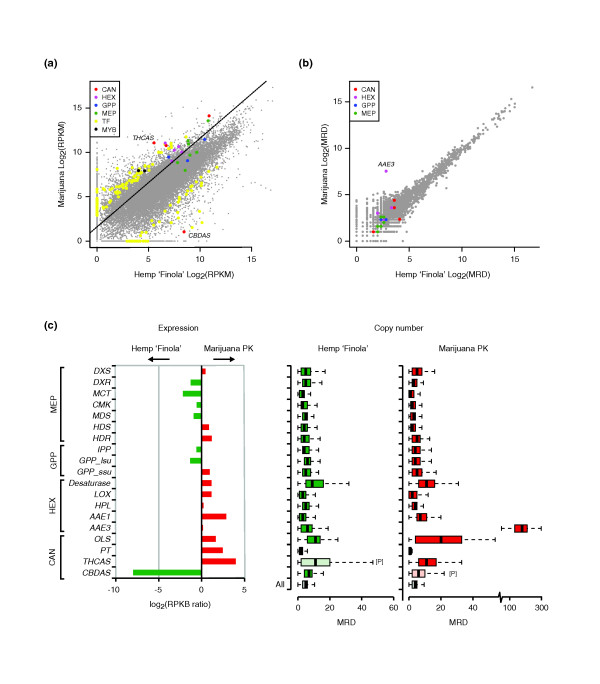
Comparison of gene expression in female cannabis flowers, and gene copy number, between marijuana (PK) and hemp ('Finola'). (a) A scatter plot of RNA-Seq read counts for all representative transcripts in marijuana and hemp, expressed as log2 RPKM. Specific subsets of transcripts are shown in color, as indicated in the key. The dashed line represents the relative enrichment of trichomes in the marijuana strain, inferred from the ratio in expression of trichome-specific genes, as defined in the text. Gene symbols/abbreviations: CAN - known and putative cannabinoid pathway genes; HEX - putative hexanoate pathway genes; GPP - GPP pathway genes; MEP - MEP pathway genes; TF - putative transcription factors according to PFAM, with at least a 4-fold change in expression in PK relative to 'Finola'; MYB - Myb-domain transcription factors previously suggested as trichome regulators. (b) A scatter plot of the log2 median read depth (MRD) of genomic DNA-Seq reads that aligned uniquely to the PK transcriptome. Genomic reads were trimmed to a length of 32 bases prior to alignment with Bowtie, to allow for mapping close to exon junctions. The lack of outliers in the scatter plot indicates that there have been relatively few changes in gene copy number between marijuana and hemp. (c) The relative RNA-Seq expression of individual genes in the cannabinoid pathway and precursor pathways (is shown on the left), adjusted for enrichment of trichome-specific genes (i.e. relative to the dashed line in panel a). The median genomic DNA read depth for the same genes is shown on the right. The box plots reflect the variation in the depth of coverage of uniquely aligned genomic DNA reads across each transcript, with the median coverage distribution across all transcripts shown as reference (All). Reads that are likely derived from pseudogenes are marked by the symbol [P]. While there is increased expression of most cannabinoid genes in the HEX and CAN pathways (left) in PK, this does not appear to be due to an increased representation of these genes in the PK genome relative to the 'Finola' genome (right).